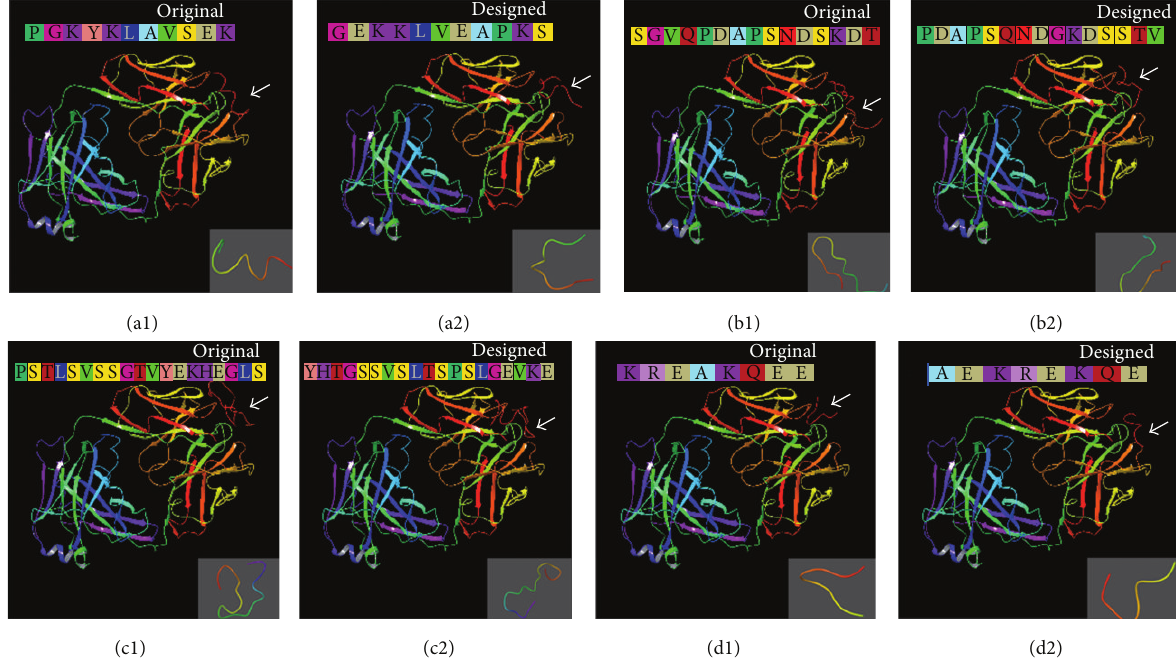
Figure 10: Interaction of antibody with original and designed oligopeptides; arrow represents binding site of oligopeptide with antibody, as shown in the lower right side of each figure. (a1) represents original PGKYKLAVSEK, (a2) represents designed oligopeptide GEKKLVEAPKS, (b1) represents original SGVQPDAPSNDSKDT, (b2) represents designed oligopeptide PDAPSQNDGKDSSTV, (c1) represents original PSTLSVSSGTVYEKHEGLS, (c2) represents designed oligopeptide YHTGSSVSLTSPSLGEVKE, (d1) represents original KREAKQEE, and (d2) designed oligopeptide